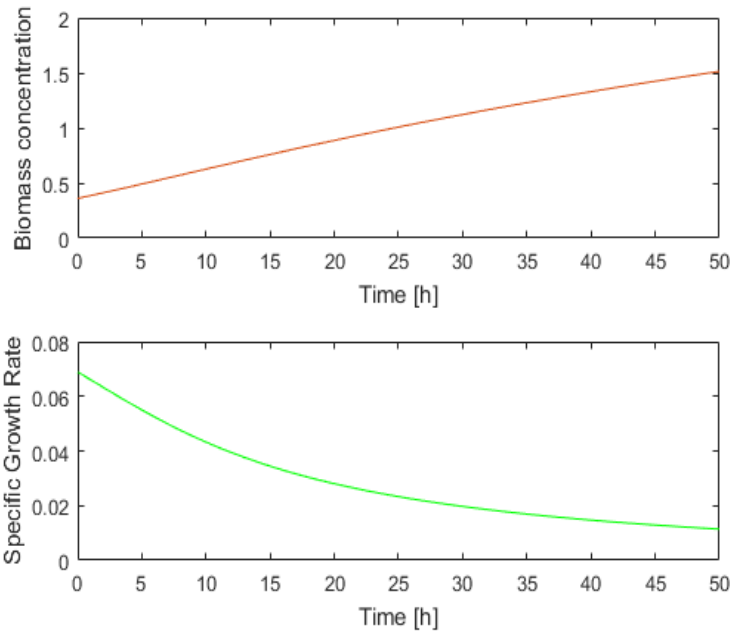
Figure 4. Evolution of x 1 ( t ) and SGR( t ) over 50 h.